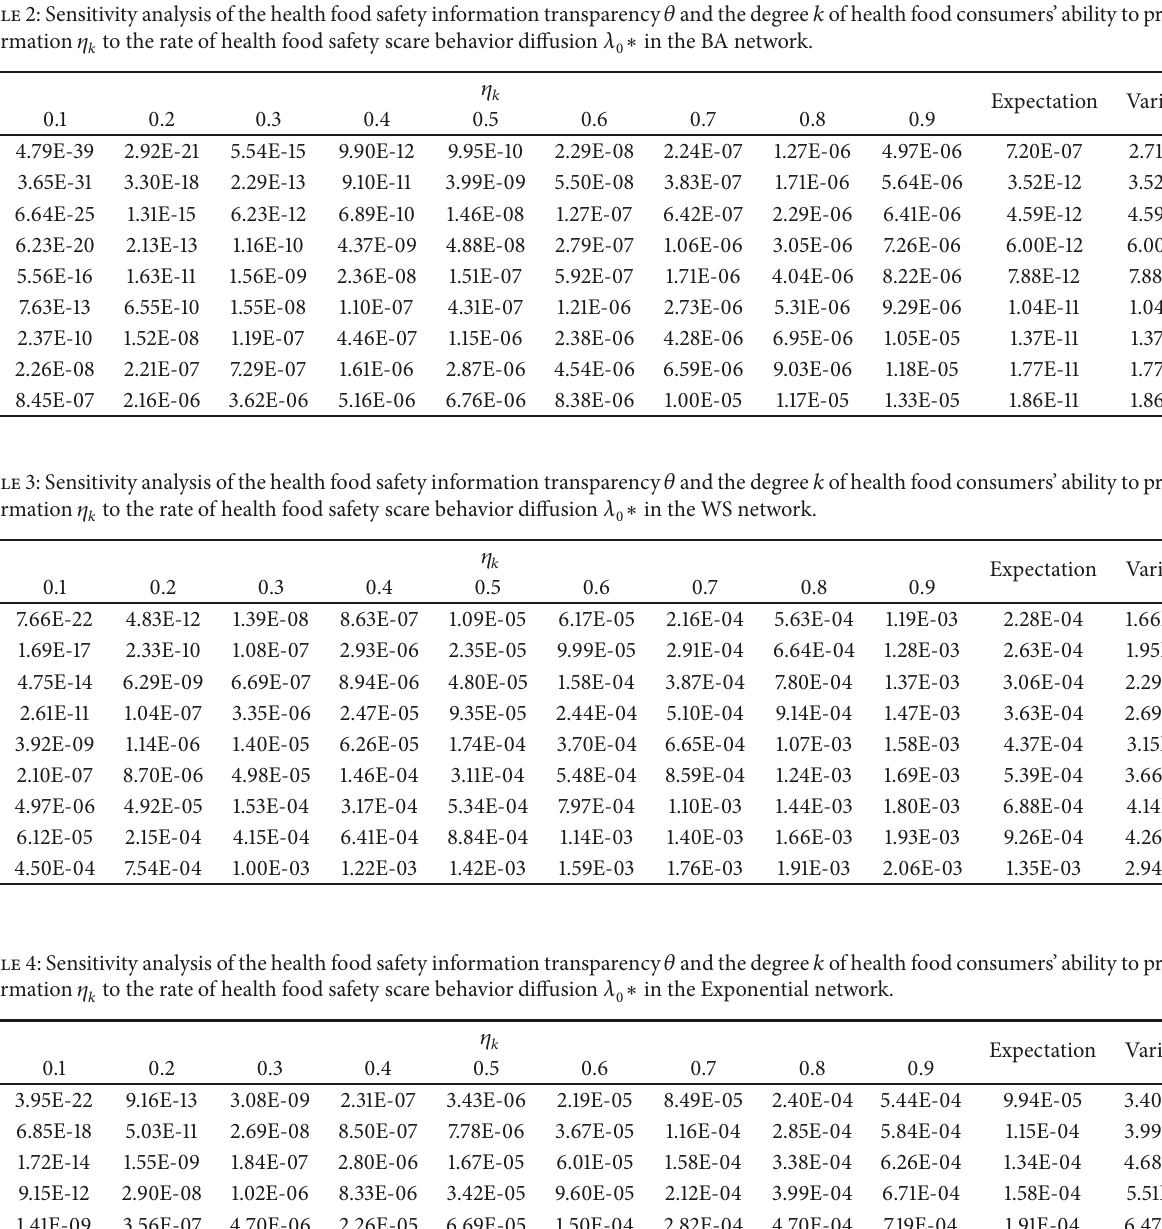
Table 2: Sensitivity analysis of the health food safety information transparency 𝜃 and the degree 𝑘 of health food consumers’ability to process information 𝜂 𝑘 to the rate of health food safety scare behavior diffusion 𝜆 0 ∗ in the BA network. 𝜃